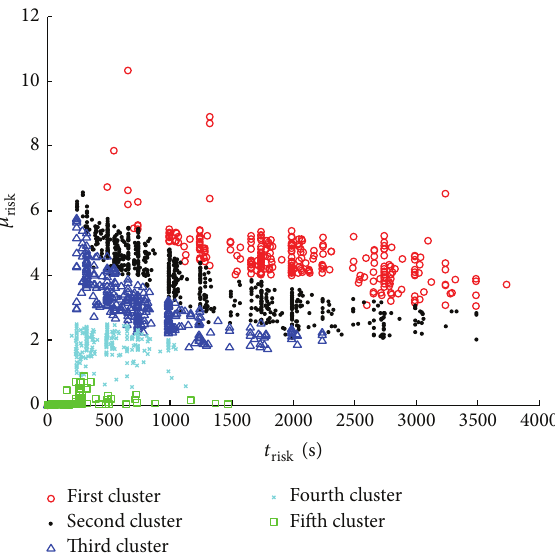
Figure 13: Clustering